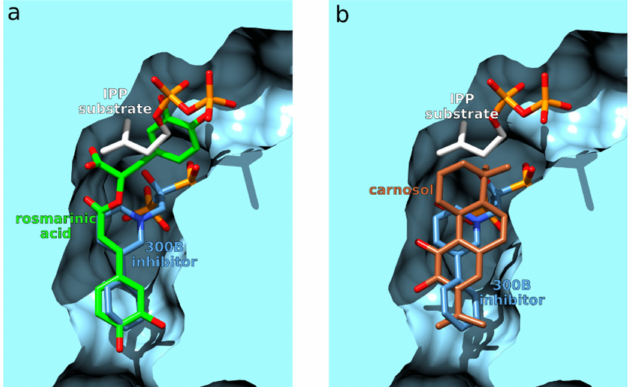
Figure 12. Comparison of ligand binding to farnesyl pyrophosphate synthase (blue surfaces). ( a ) Com- parison between the crystal ligand 300B (blue carbons) and rosmarinic acid (green carbons) binding. ( b ) Comparison between the crystal ligand 300B (blue carbons) and carnosol (brown carbons) binding. The enzyme substrate isopentenyl pyrophosphate (IPP) was not present during the inverse docking but is shown for comparison purposes using white carbons.